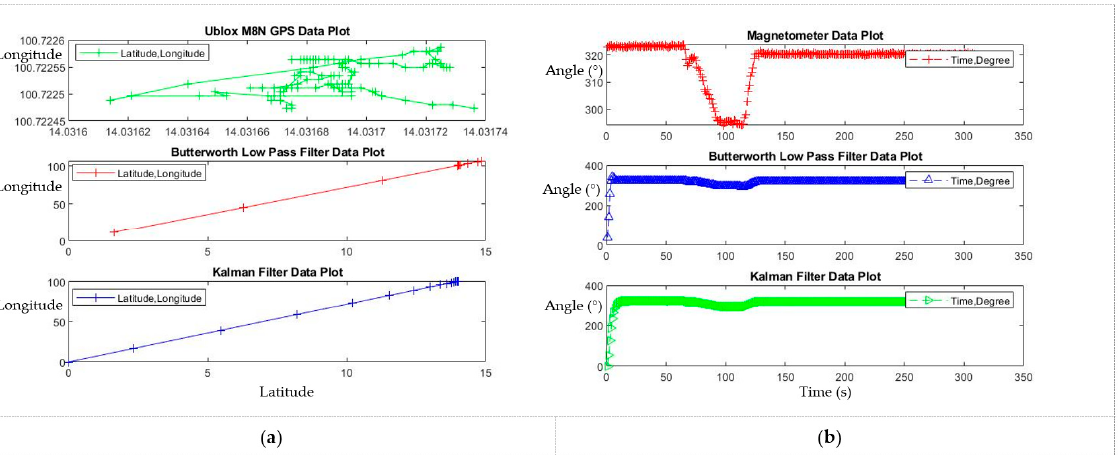
Figure 5. Comparison of noise and error correction data plot using filter. ( a ) GPS Data Plot; ( b ) Magnetometer Data Plot.